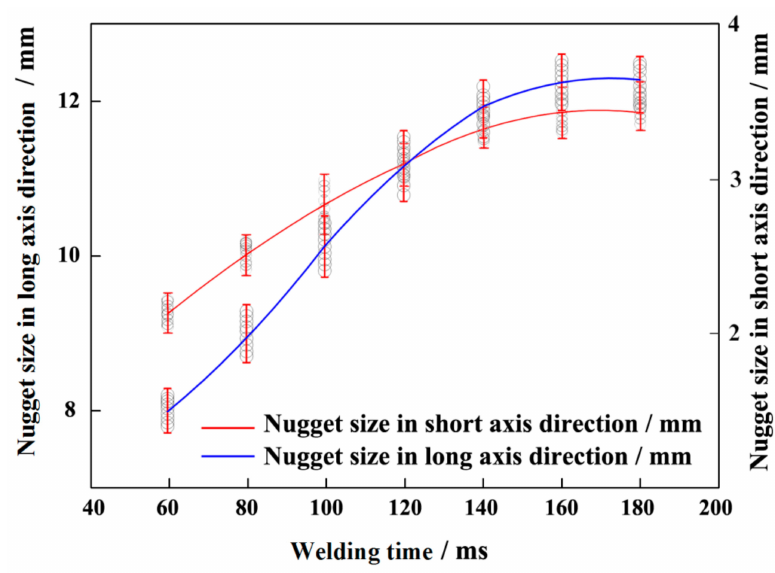
Figure 11. Influence of welding time on the dimensions of nuggets.